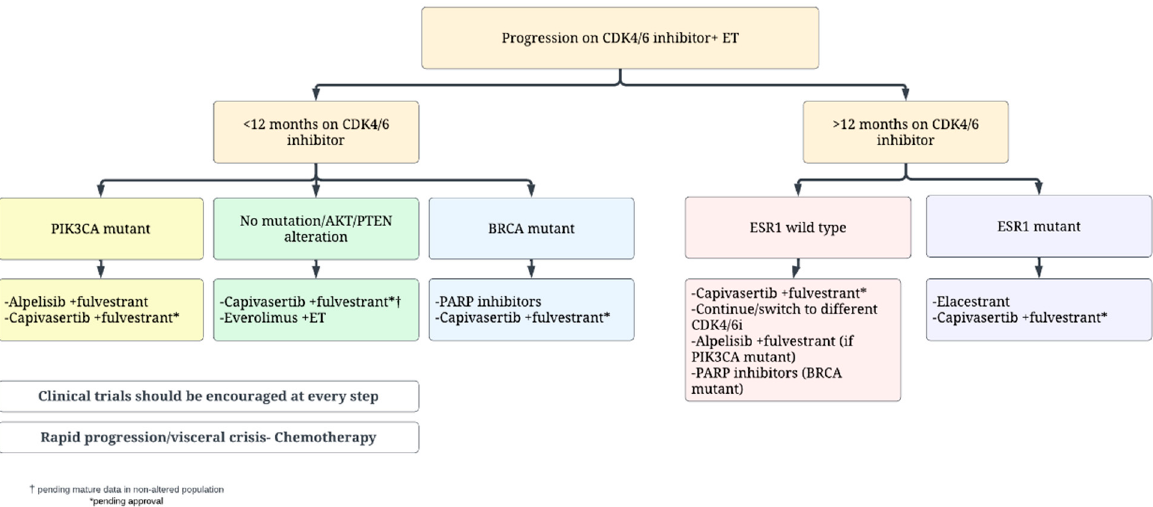
Figure 1. Proposed second line treatment algorithm for patients with hormone receptor positive MBC.